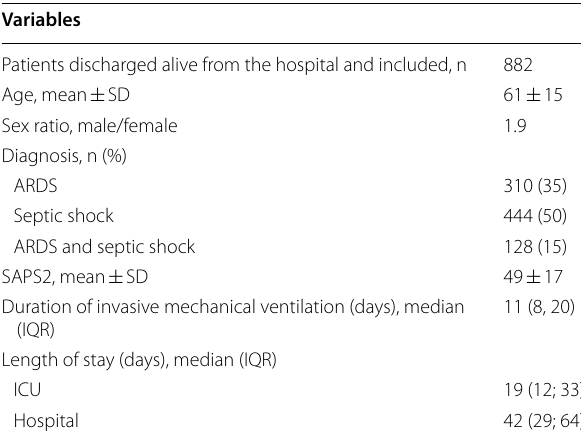
Cluster analysis of healthcare use trajectories (Fig. 2b) Table 1 Patient characteristics